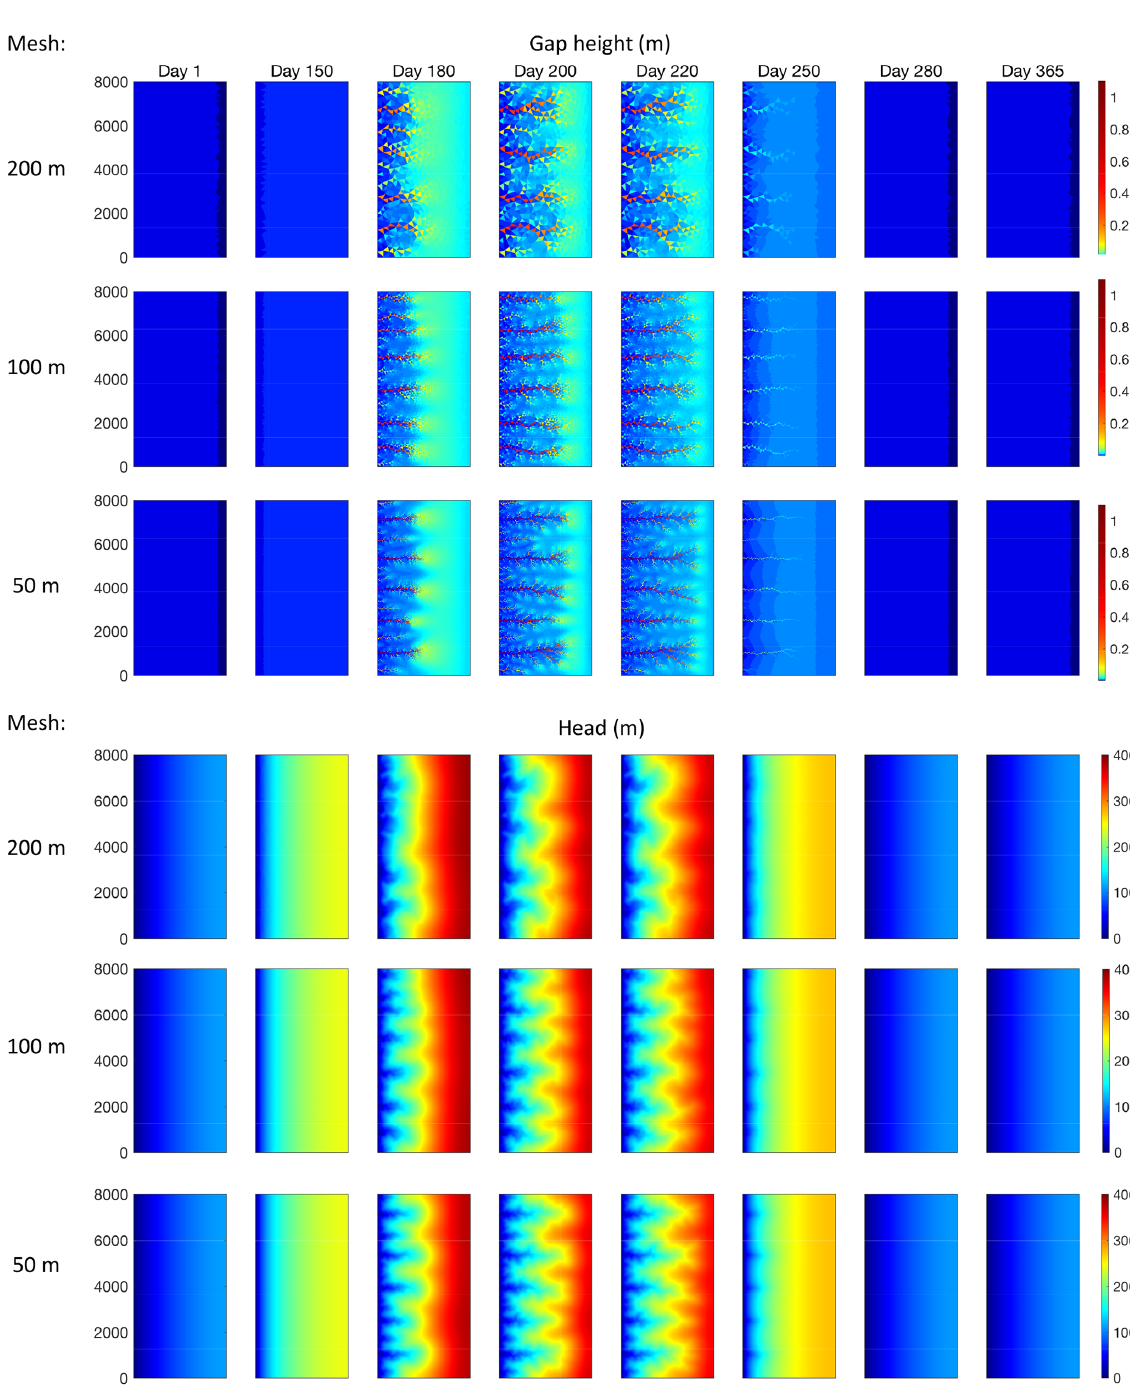
Figure 7. Mesh dependence shown for the transient example with distributed input (see Sect. 3.3 and Figs. 5 and 6) with typical element edge lengths of 50, 100, and